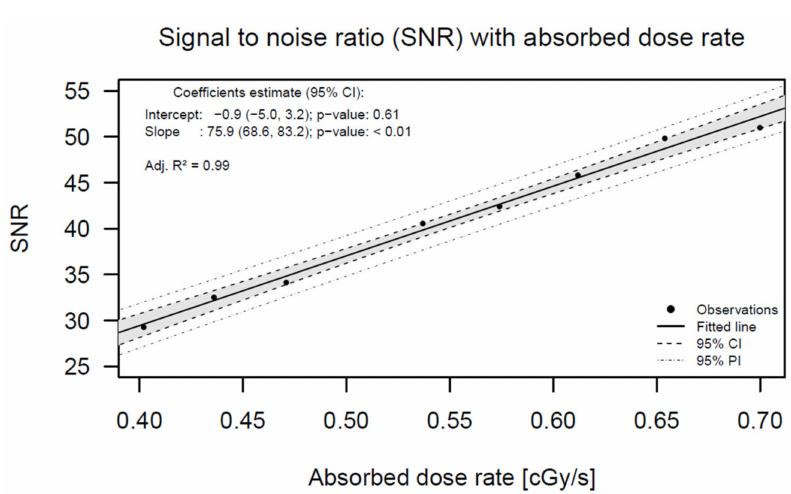
Figure 3. SNR (signal-to-noise ratio); SNR has no units because signal and noise units are the